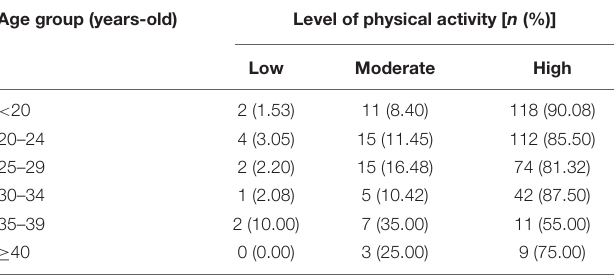
TABLE 1 | Levels of physical activity stratified by age